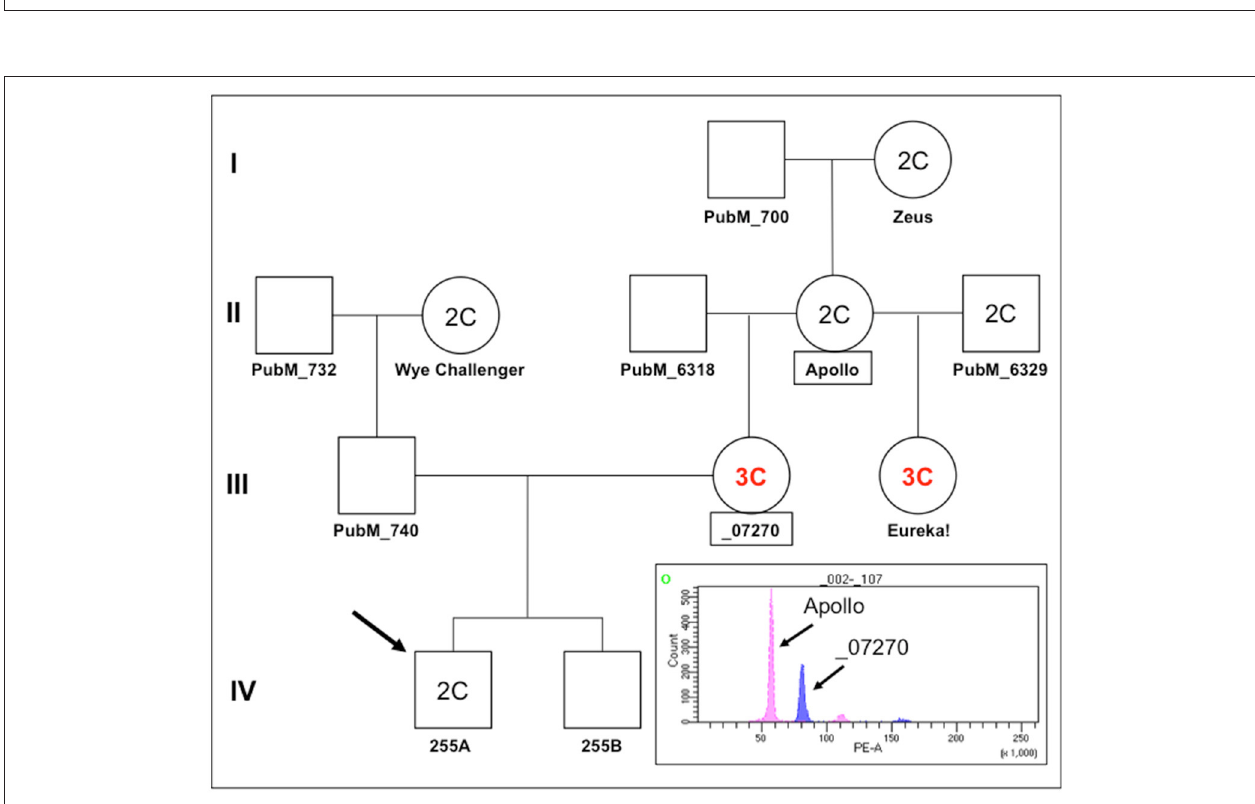
FIGURE 8 | Pedigree of Apollo family and FACS. A partial pedigree of hops relevant to this study was constructed and annotated. Fluorescence-activated cell sorting was carried out for several plants in the Apollo family in relation to plant 255A (IV,1, the proband/arrow). Where determined by FACS, the DNA content is indicated as either 2C or 3C. The histogram showing fluorescence intensity peaks for nuclei from Apollo around 56 PE-A (2C) and for nuclei from _07270 around 80 PE-A (3C). Smaller fluorescence peaks at about double each main peak can also be observed at ∼ 110 and ∼ 160, indicative of nuclei that have likely undergone one round of